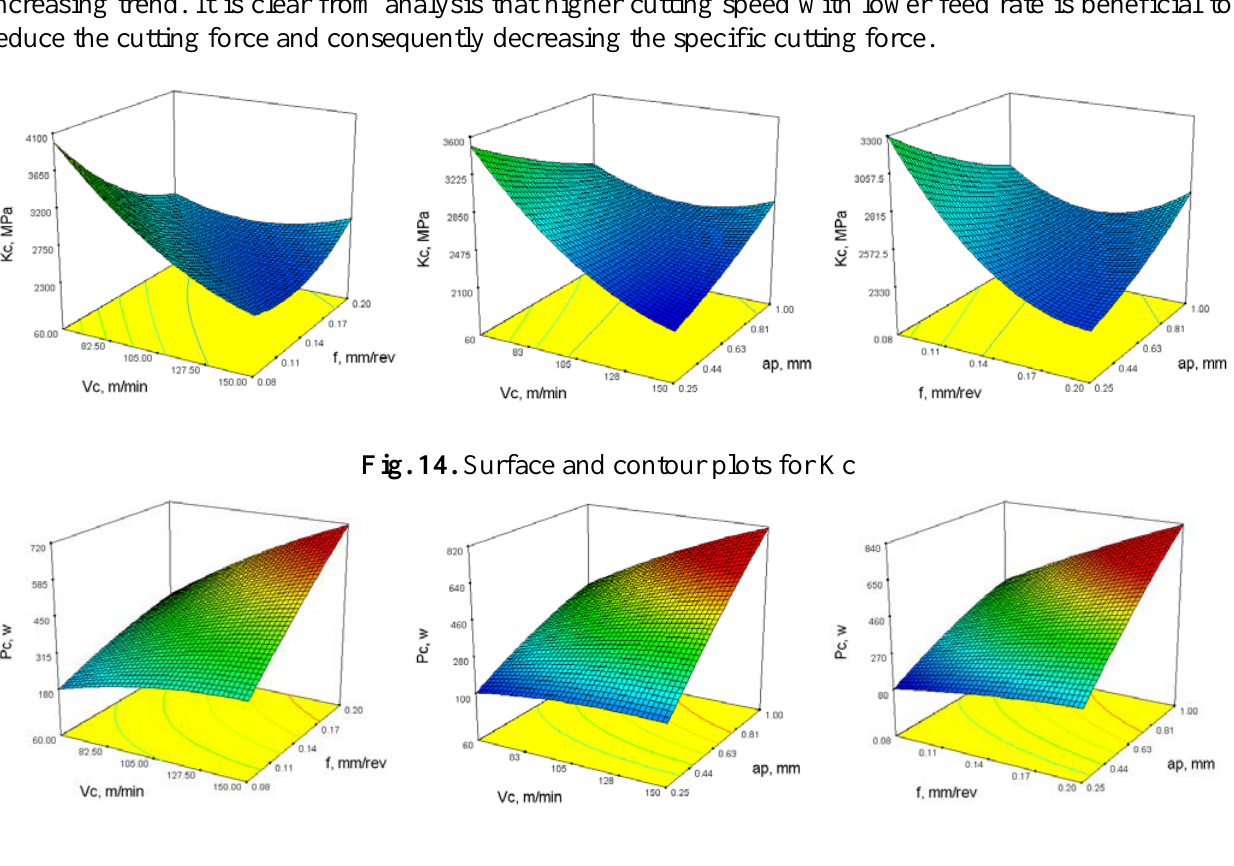
Fig. 15. Surface and contour plots for